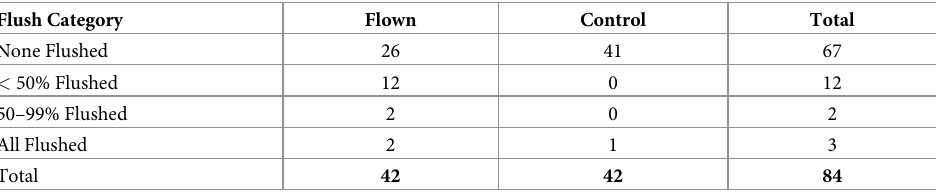
Table 3. Summary statistics for a multinomial classification of flushes on a whole wetland perspective basis. We conducted a total of 42 flights during the spring and early summer of